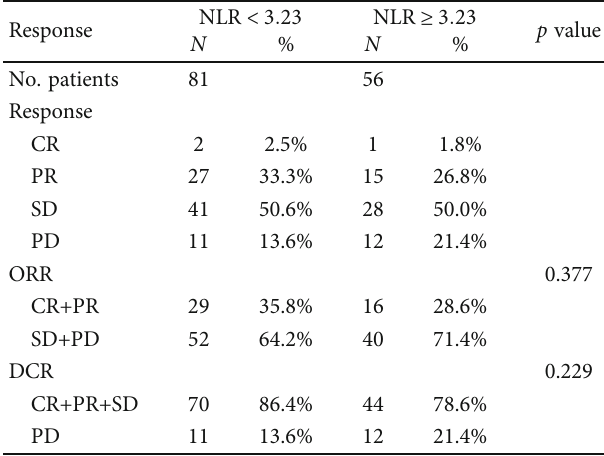
Table 2: Treatment response in the NLR < 3 : 23 group and in the NLR ≥ 3 : 23